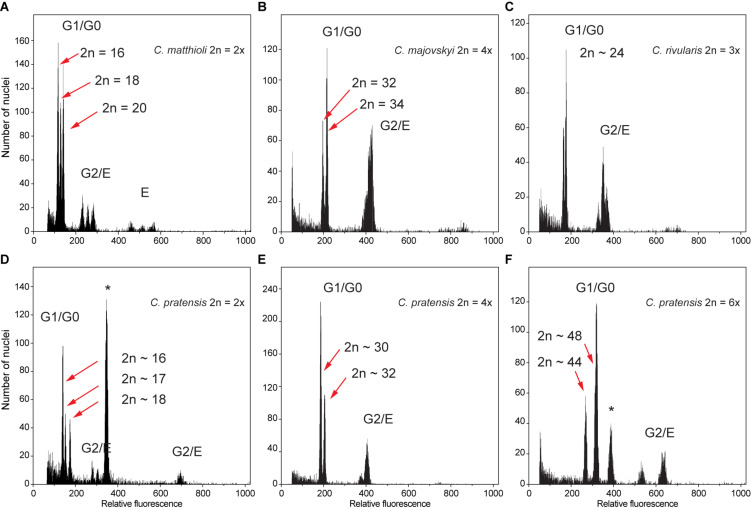
Flow cytometric histograms of DAPI-stained nuclei obtained from simultaneous analyses of multiple samples from the same populations, documenting intraspecific divergence in nuclear DNA content in the Cardamine species under study caused by both aneuploidy and dysploidy. (A) Diploid C. matthioli, population Mat_CAJ; (B) tetraploid C. majovskyi, population Maj_KIS; (C) triploid C. rivularis, population Riv_KAT; (D) diploid C. pratensis, population Prat_DE5; (E) tetraploid C. pratensis, population Prat_AIS; (F) hexaploid C. pratensis, population Prat_GOR. Letters denote peaks of nuclei corresponding to different phases of the cell cycle (G0–G2) and/or levels of endopolyploidy (E); the internal standards Solanum pseudocapsicum and Bellis perennis used in analyses (D,F), respectively, are marked by an asterisk. For locality codes see Supplementary Data 1.